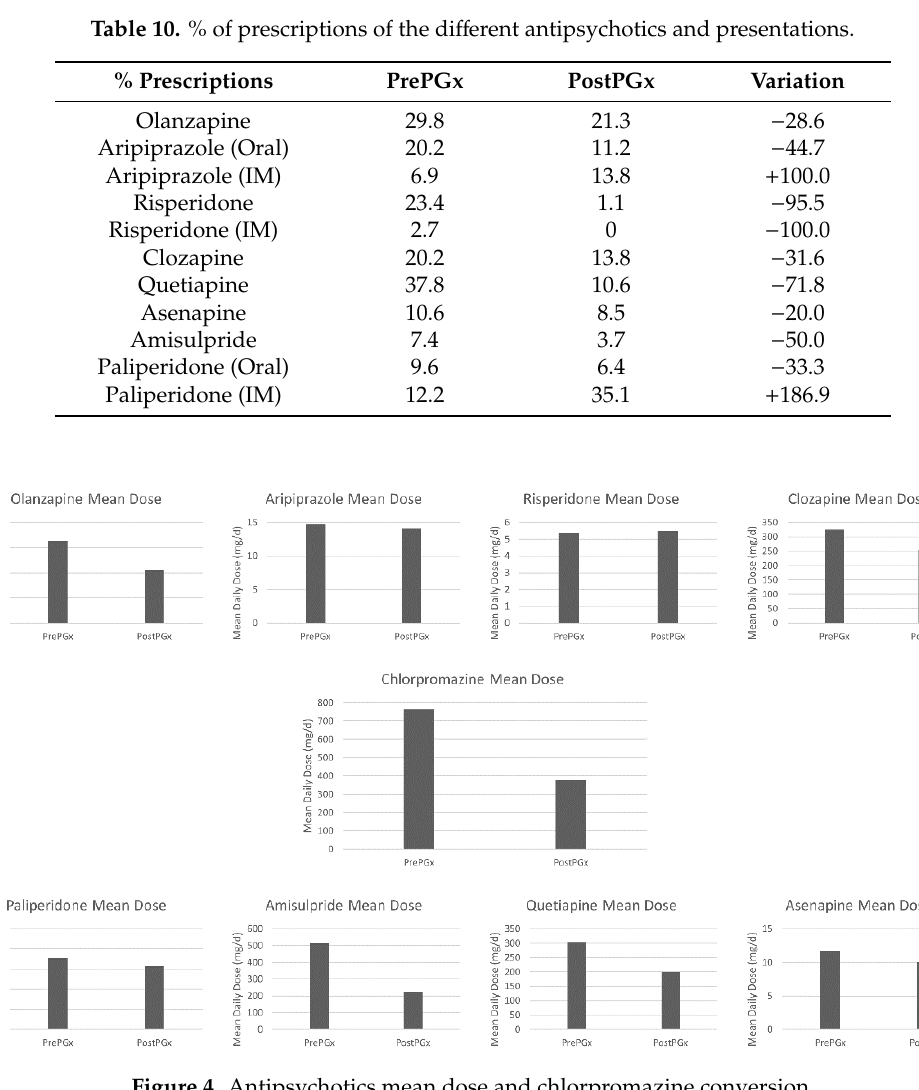
Figure 4. Antipsychotics mean dose and chlorpromazine conversion. Table 11. Within-patient variation on antipsychotic daily